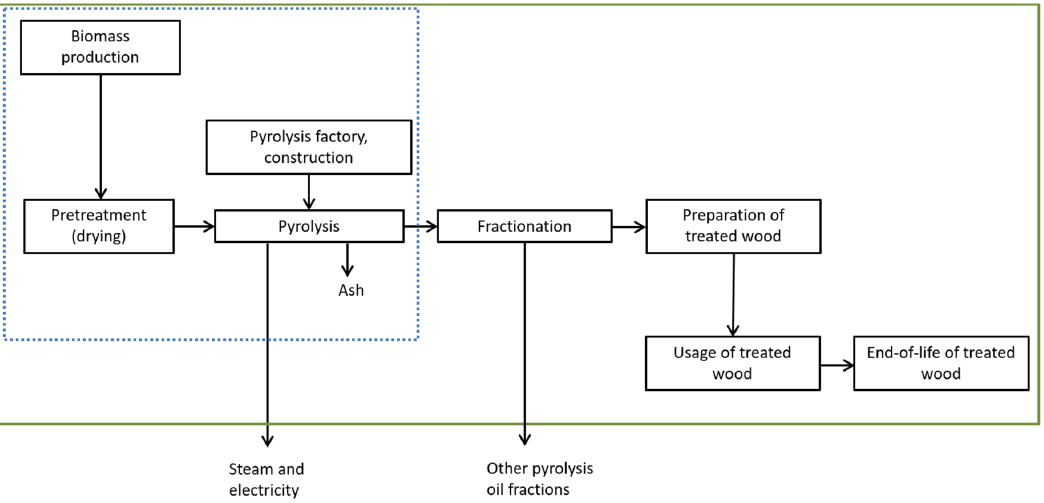
Figure 1. System boundaries of the life cycle assessment (LCA). Blue dotted line: The system boundaries of the pyrolysis oil LCA. Green solid line: The system boundaries of the wood modification LCA. Life cycle inventory (LCI) data was obtained from within the Dutch-German Interreg project Groen Goud as well as the Horizon2020 projects Bio4Products and Residue2Heat. Additional data was obtained from open literature and the Ecoinvent database (version 3.4, compiled in April 2018). The